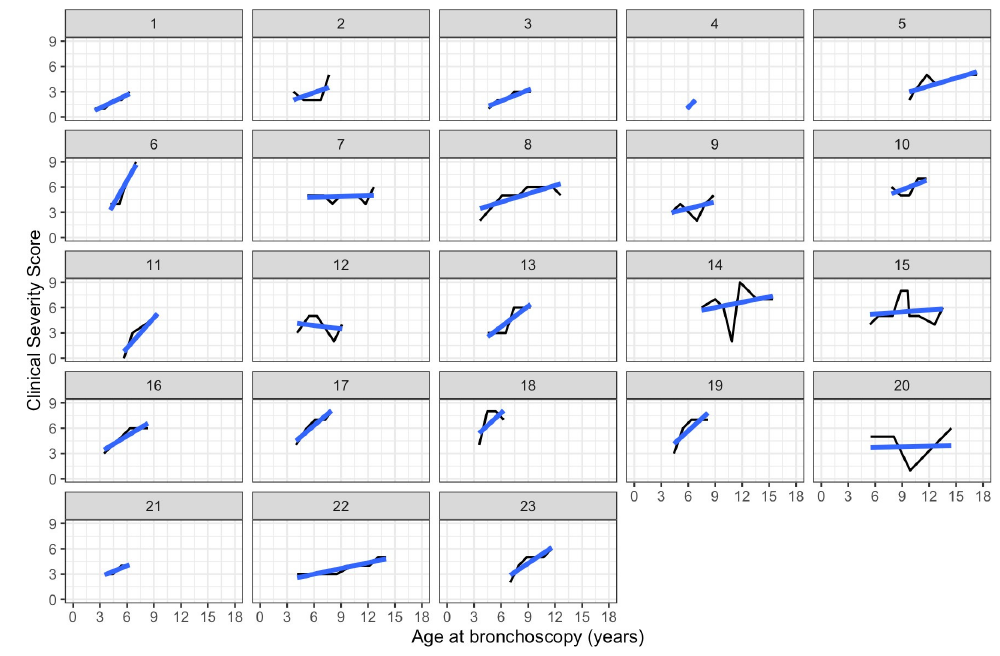
Figure 5. Individual slope of progression of airway disease, expressed as the airway severity score for each subject.